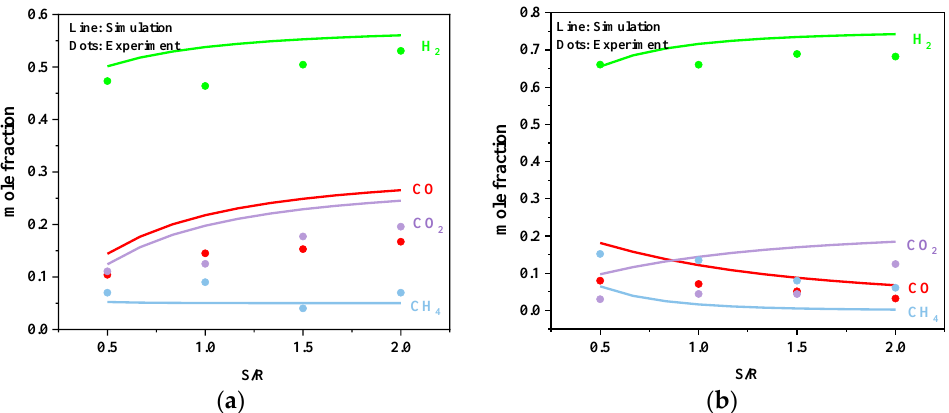
Figure 17. ( a ) Effect of S/R on gas distribution for the raw syngas, ( b ) Effect of S/R on gas distribution for the modified syngas.